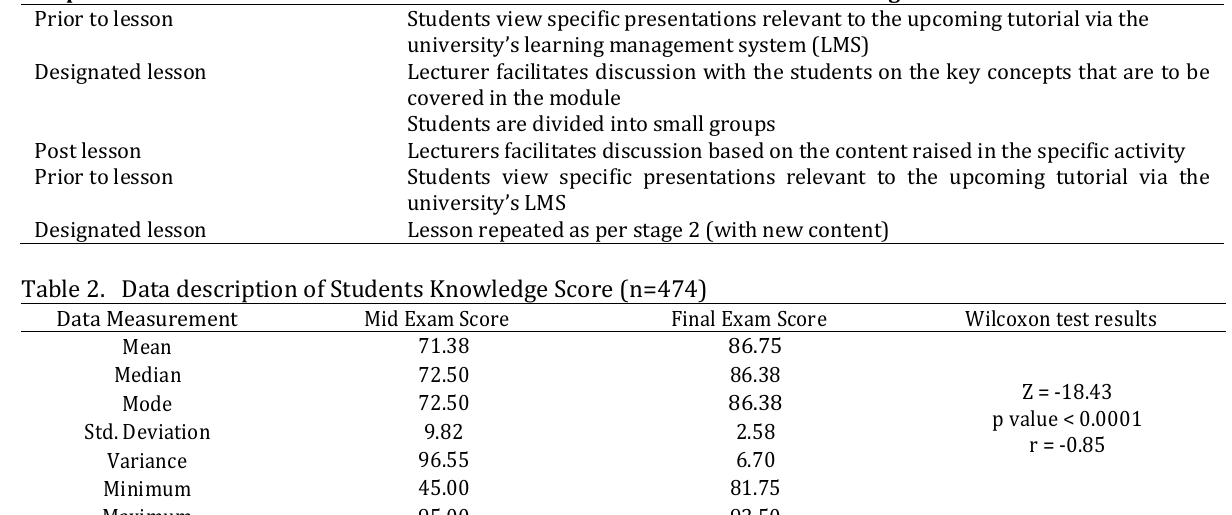
Table 1. Learning activities in blended learning Steps